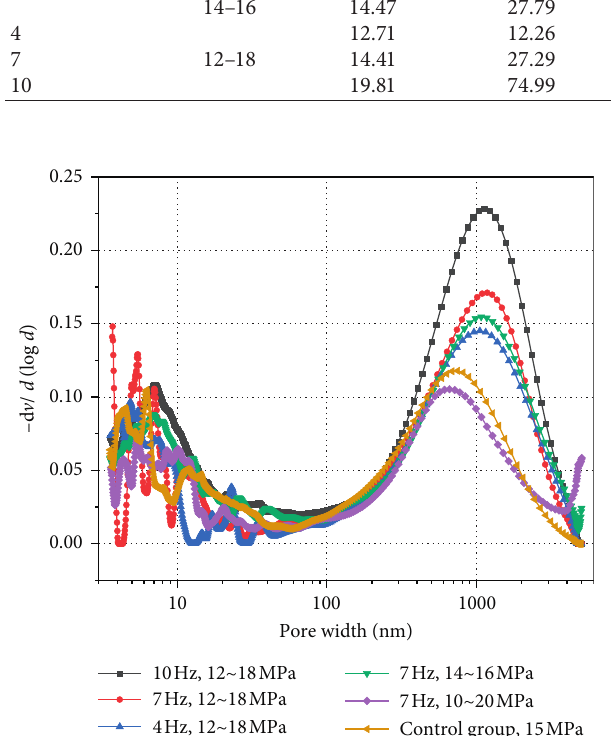
Figure 12: Distribution density functions of the pore volume under different loading